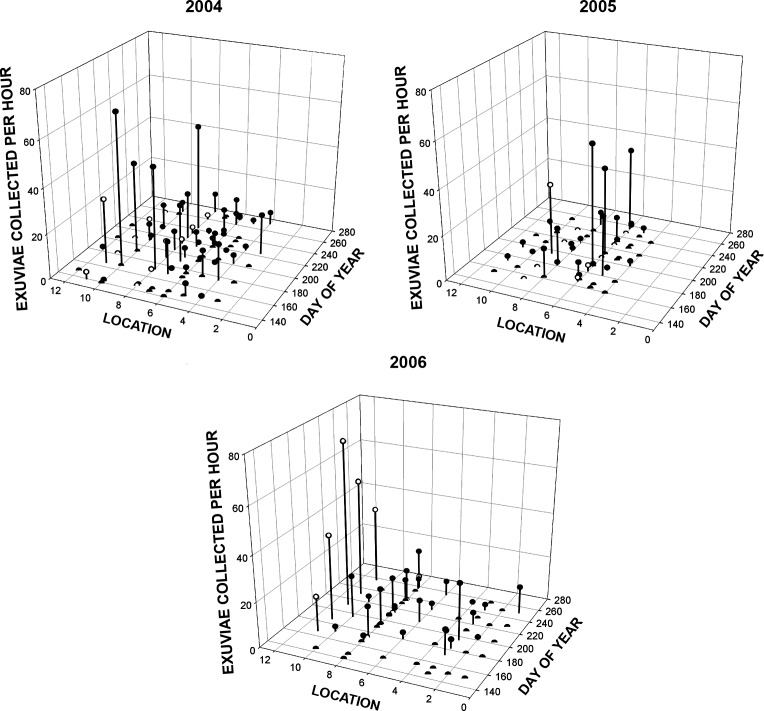
Numbers of Anax junius exuviae collected vs day of year and location (see text) for all 29 Rhode Island ponds surveyed in each of three years.In addition to those listed in Fig 5 and S2 Fig, two ponds, Amtrak and Nbground, at locations 9 and 6 respectively on the 2006 plot, were fish free (open circles). Underlying data in S5, S6 and S7 Tables.